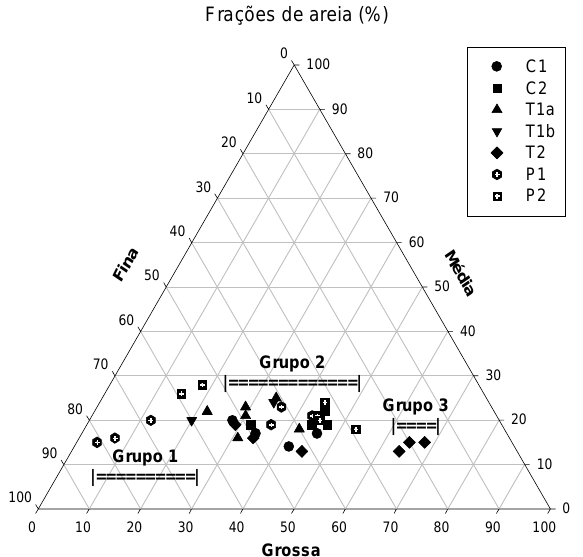
Figura 5. Distribuição das frações de areia na seqüência Latossolo-Espodossolo, sendo: Areia grossa = 2-0,5 mm; Média = 0,5-0,25 mm; Fina = 0,25-0,05 mm; Grupo 1: material selecionado pelas minhocas; Grupo 2: materiais de alteração do granito; Grupo 3: material com nódulos (perfil T2).